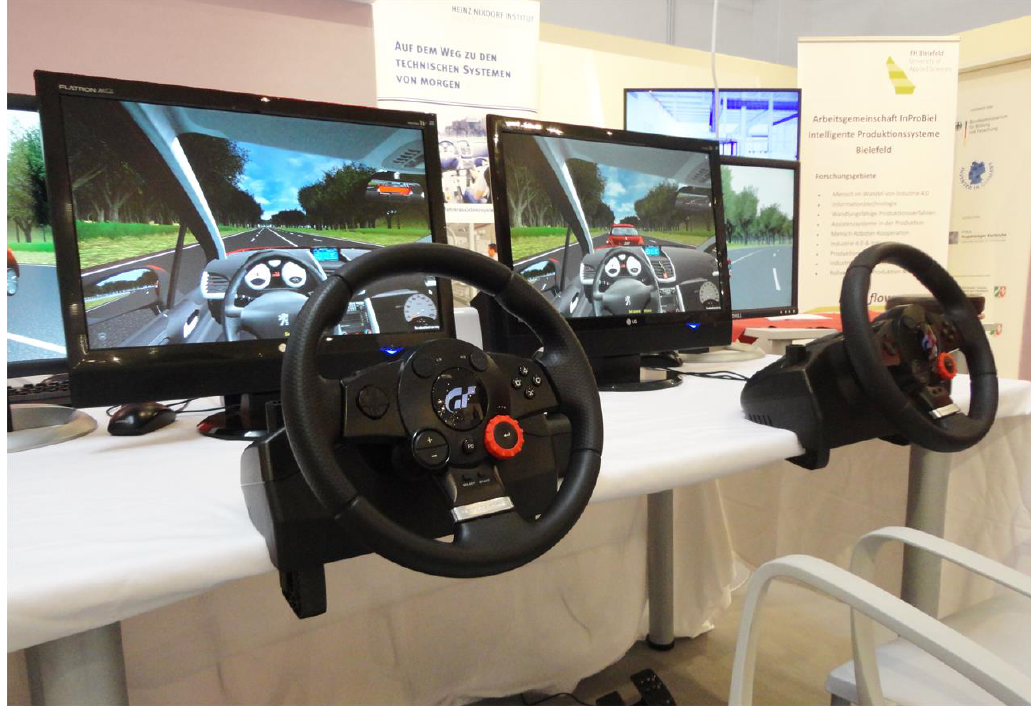
Figure 22. Established platform of networked driving simulation for the third application scenario.